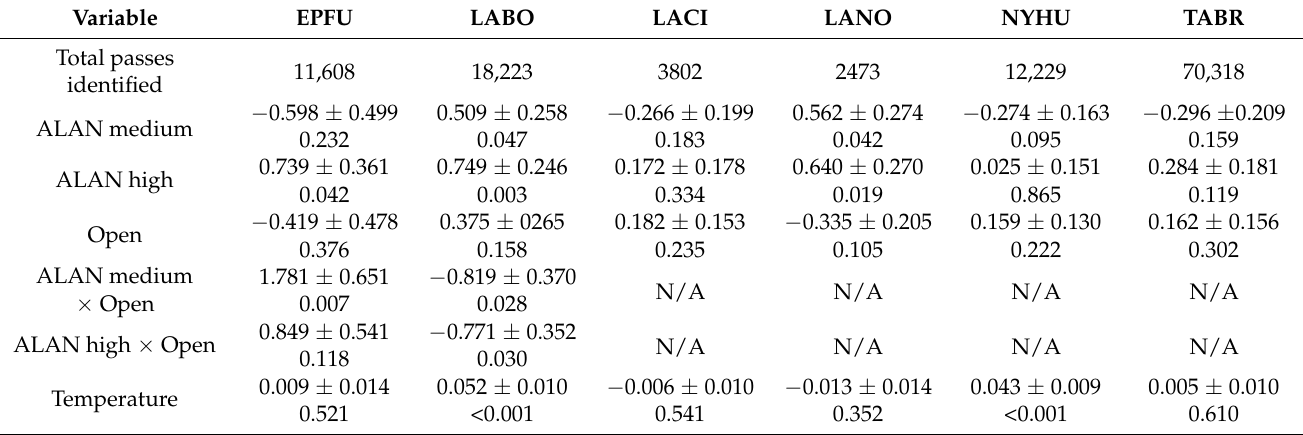
Table 2. General linear models results (regression estimate ± standard error on top, p value at bot- tom, n = 204) on species-specific bat activity in relation to ALAN, spatial complexity, and tempera- ture.